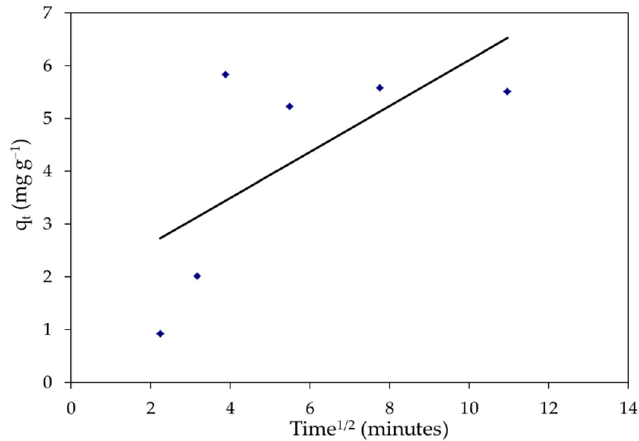
Figure 19. The intraparticle diffusion equation for the elimination of MBD onto S. latifolium. Table 5. The comparison of the first order, second-order, and intraparticle diffusion for adsorption rate constants.